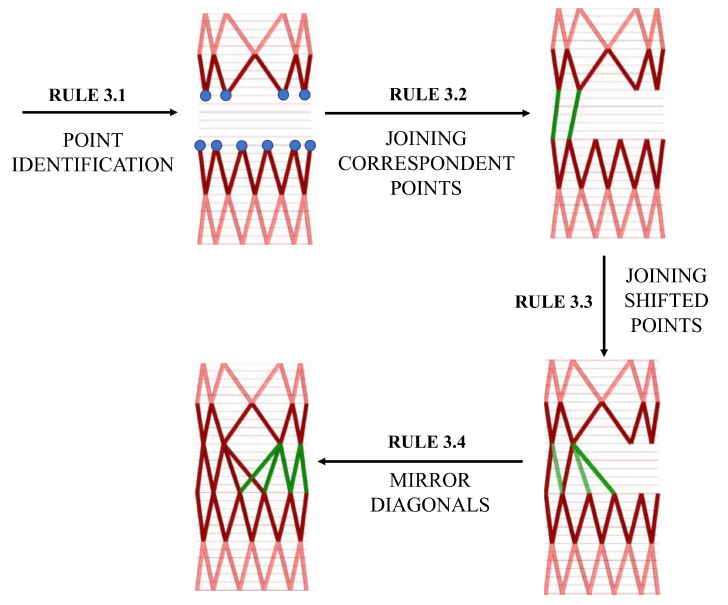
Figure 6. Rules for the construction of the transition belt.